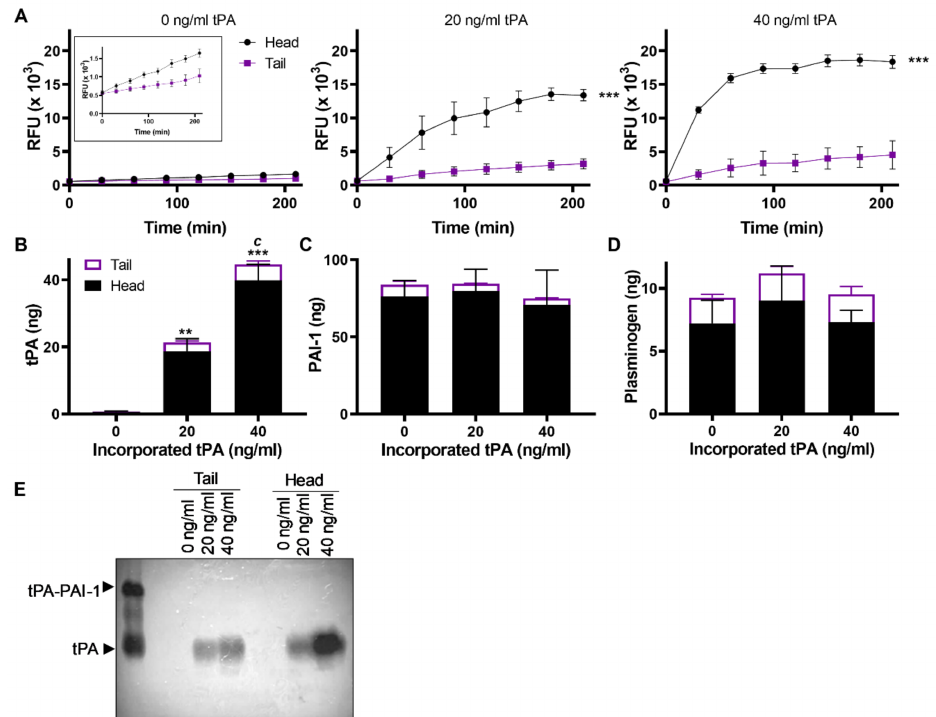
Figure 3. Incorporated tPA increased in the thrombus head. ( A ) Fibrinolysis was measured as fluorescence released in the bathing fluid from heads and tails in the absence or presence of 20 or 40 ng/mL of incorporated tPA. Inset shows the fluorescence released at 0 ng/mL of tPA on a smaller scale. ( B ) tPA, ( C ) PAI-1 and ( D ) plasminogen antigen concentrations were measured by ELISA in extracts of heads and tails. ( E ) Detection of tPA by zymography showing tPA and tPA–PAI-1 in extract of thrombus head and tail sections formed with incorporation of 0, 20 or 40 ng/mL tPA. Data shown are mean ± SEM ( n = 3). *** p < 0.001 vs. no tPA.